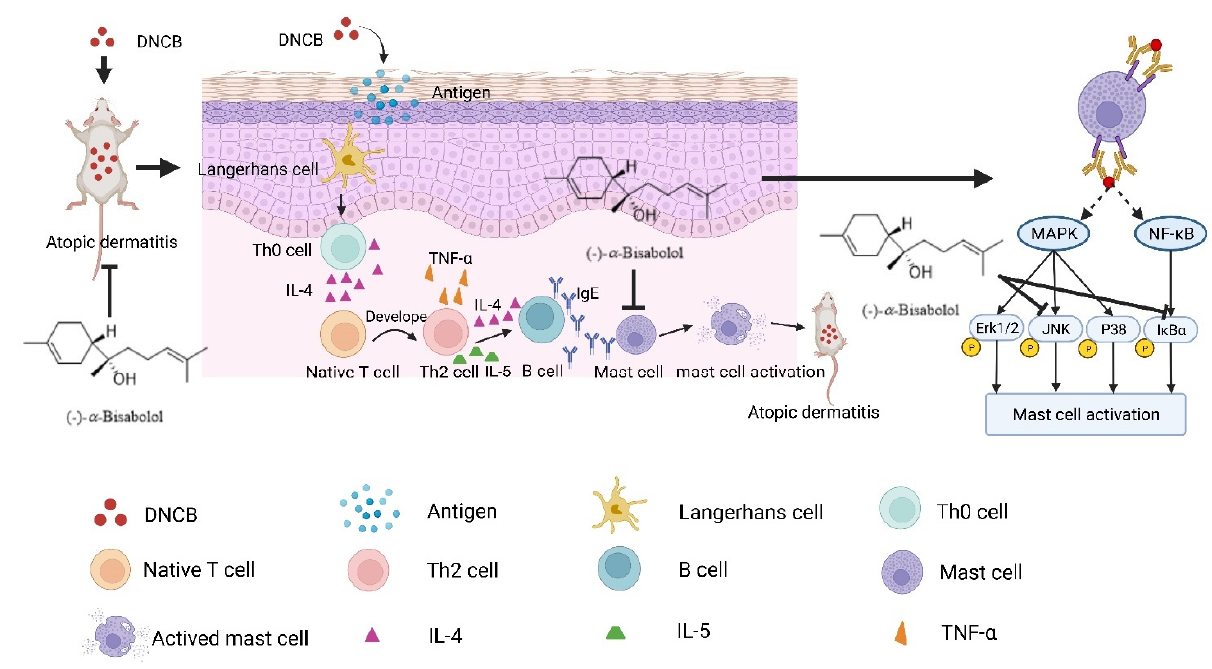
Figure 8. BIS-attenuated degranulation of mast cell by inhibiting MAPK and NF- κ B pathway in DNCB-induced atopic